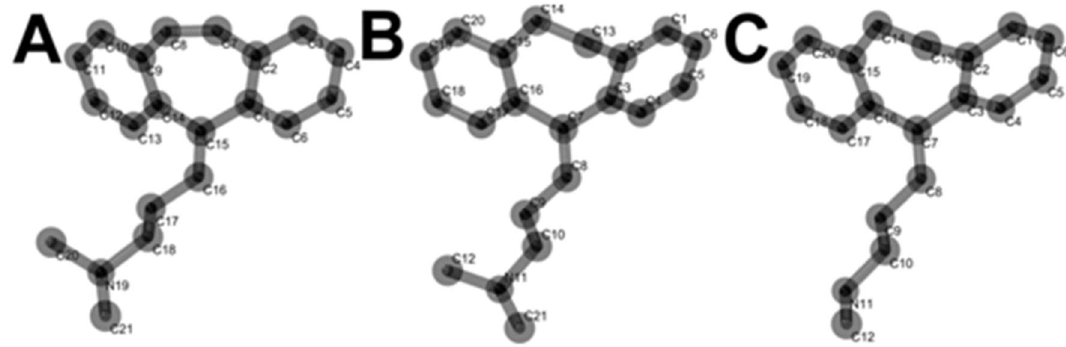
Figure 4. Lowest energy conformers of CBP ( A ), AMP ( B ) and NOR ( C ).